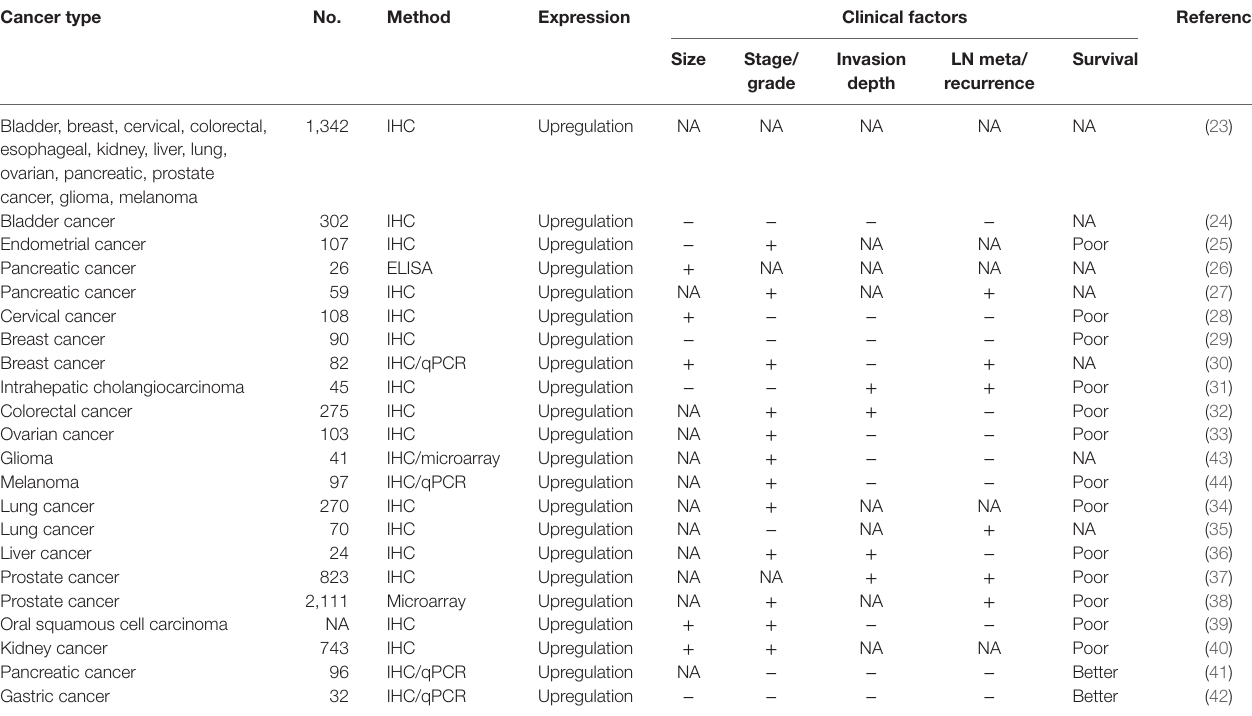
Size Stage/ invasion lN meta/ Survival grade depth recurrence